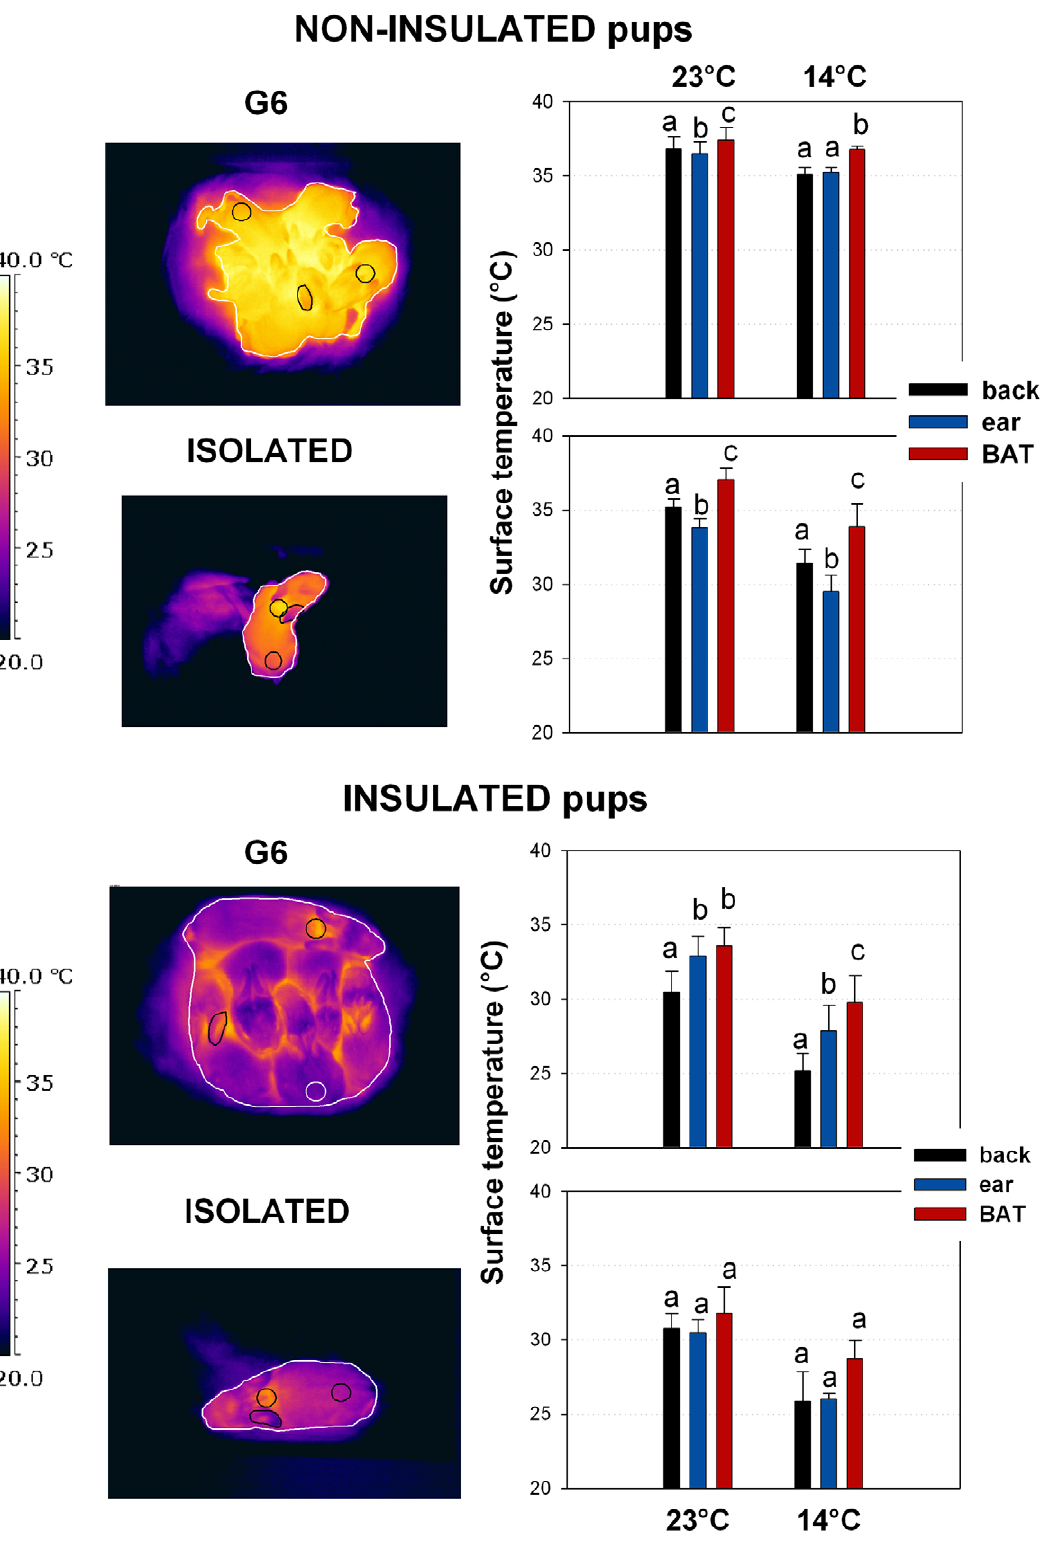
Figure 3. Surface temperature of back, ear and brown adipose tissue (BAT) of isolated (G1) and huddling (G6) pups, non-insulated and insulated, exposed at 23 6 C and 14 6 C. The results of post-hoc Tukey tests are shown by the letters a to c: same letter showed no significant difference. Left panel: Thermal images are shown for isolated (G1) and huddling (G6) non-insulated and insulated pups, exposed to an ambient temperature of 14 u C. Images show the location of circles used to compare surface temperature (total area, back, ear, brown adipose tissue (BAT)).